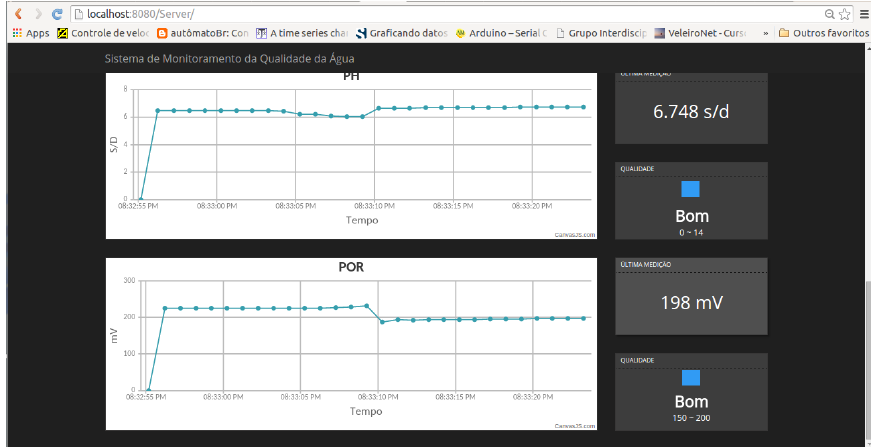
Figure 16. The web interface implemented for showing data on the Internet (already running at www.natalnet.br/nboat).